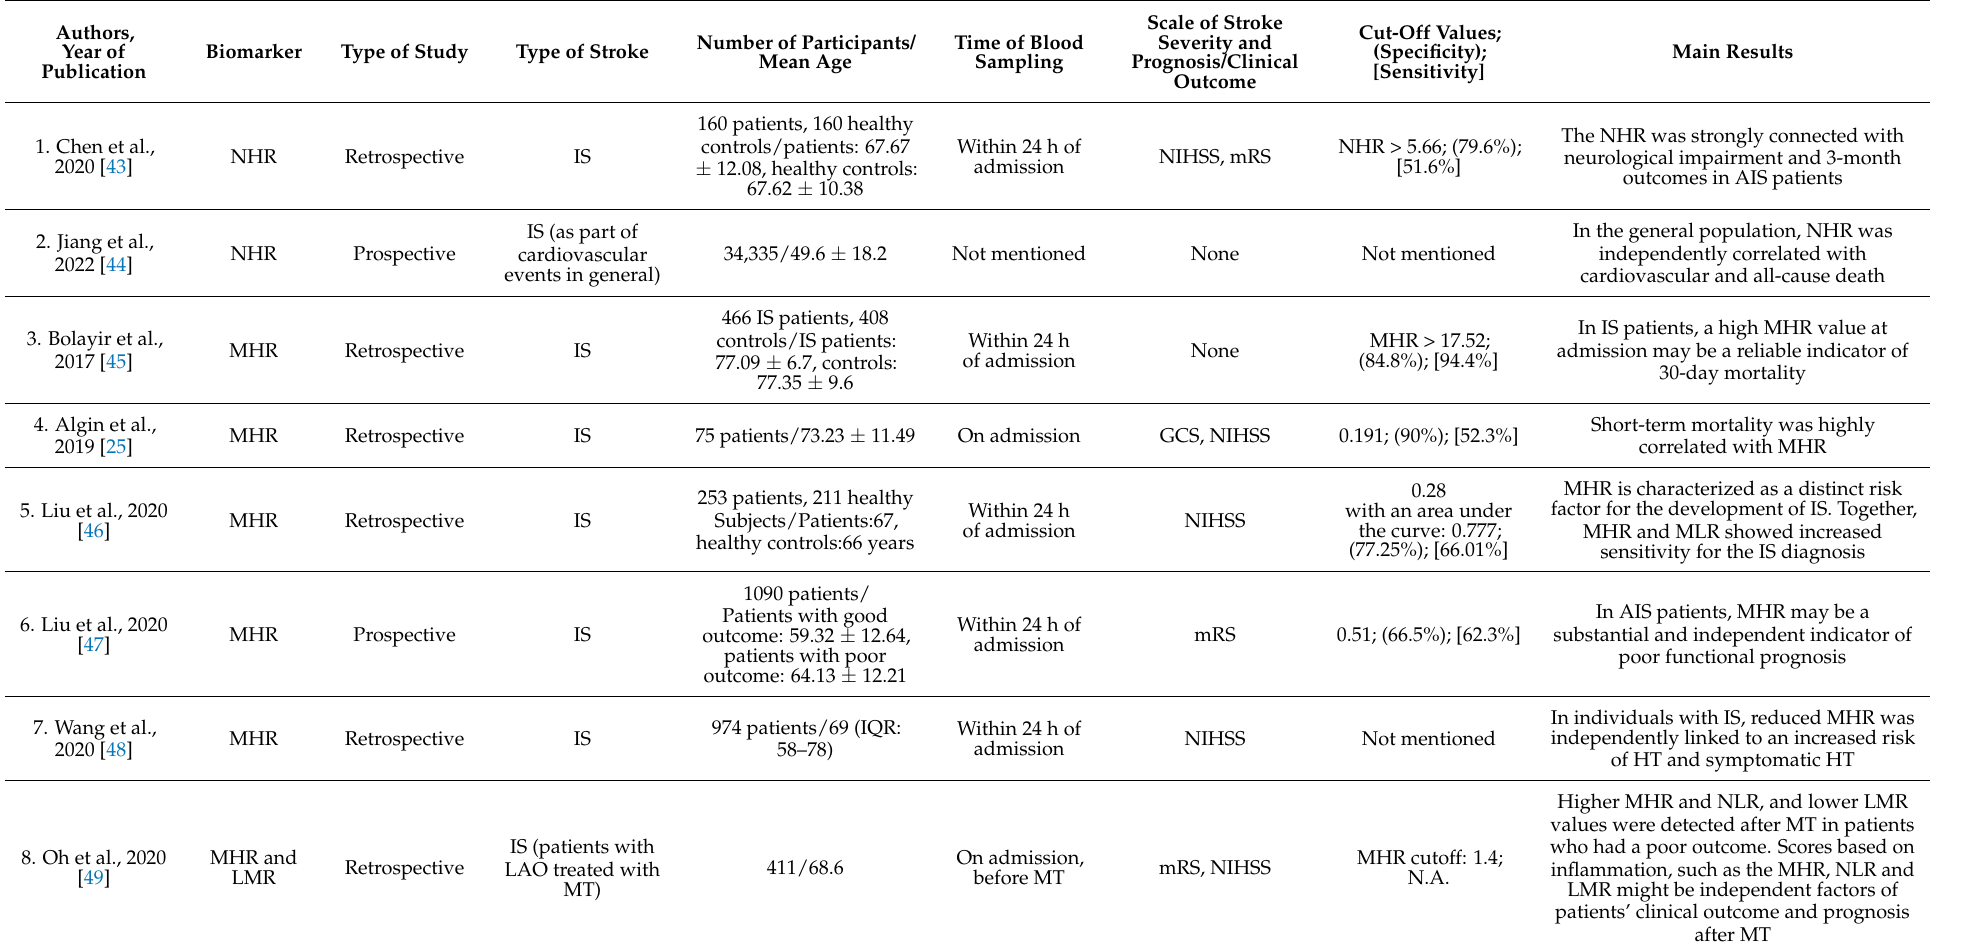
Table 1. Basic characteristics of the 13 included